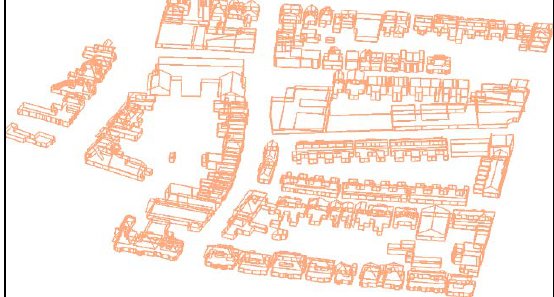
Figure 7. 3D building models sample for verification